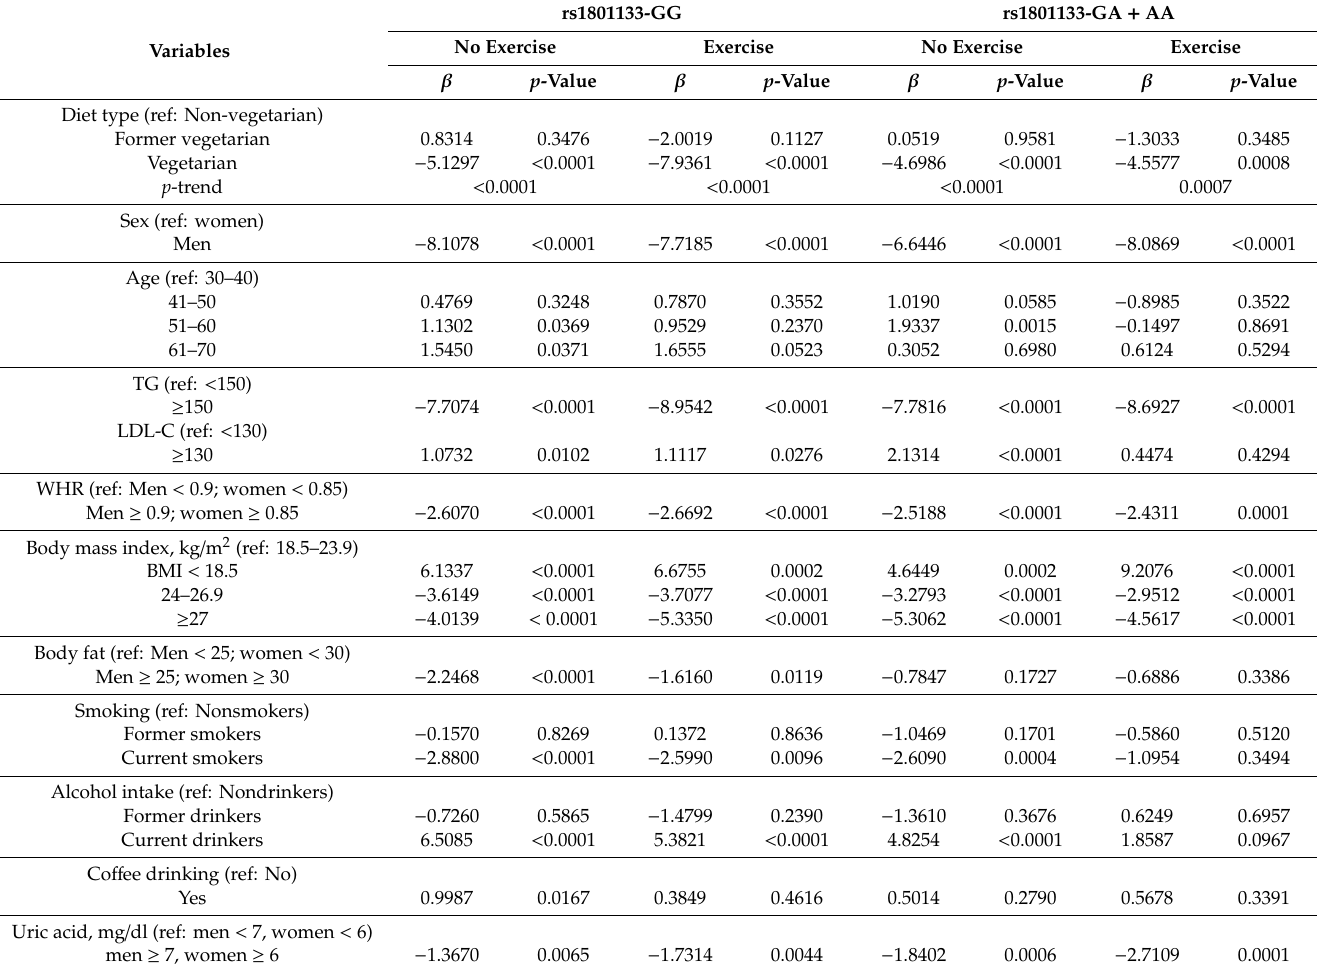
Table 3. Association of vegetarian diet with HDL-C based on rs1801133 genotypes and exercise exposure. rs1801133-GG rs1801133-GA + AA Exercise Variables